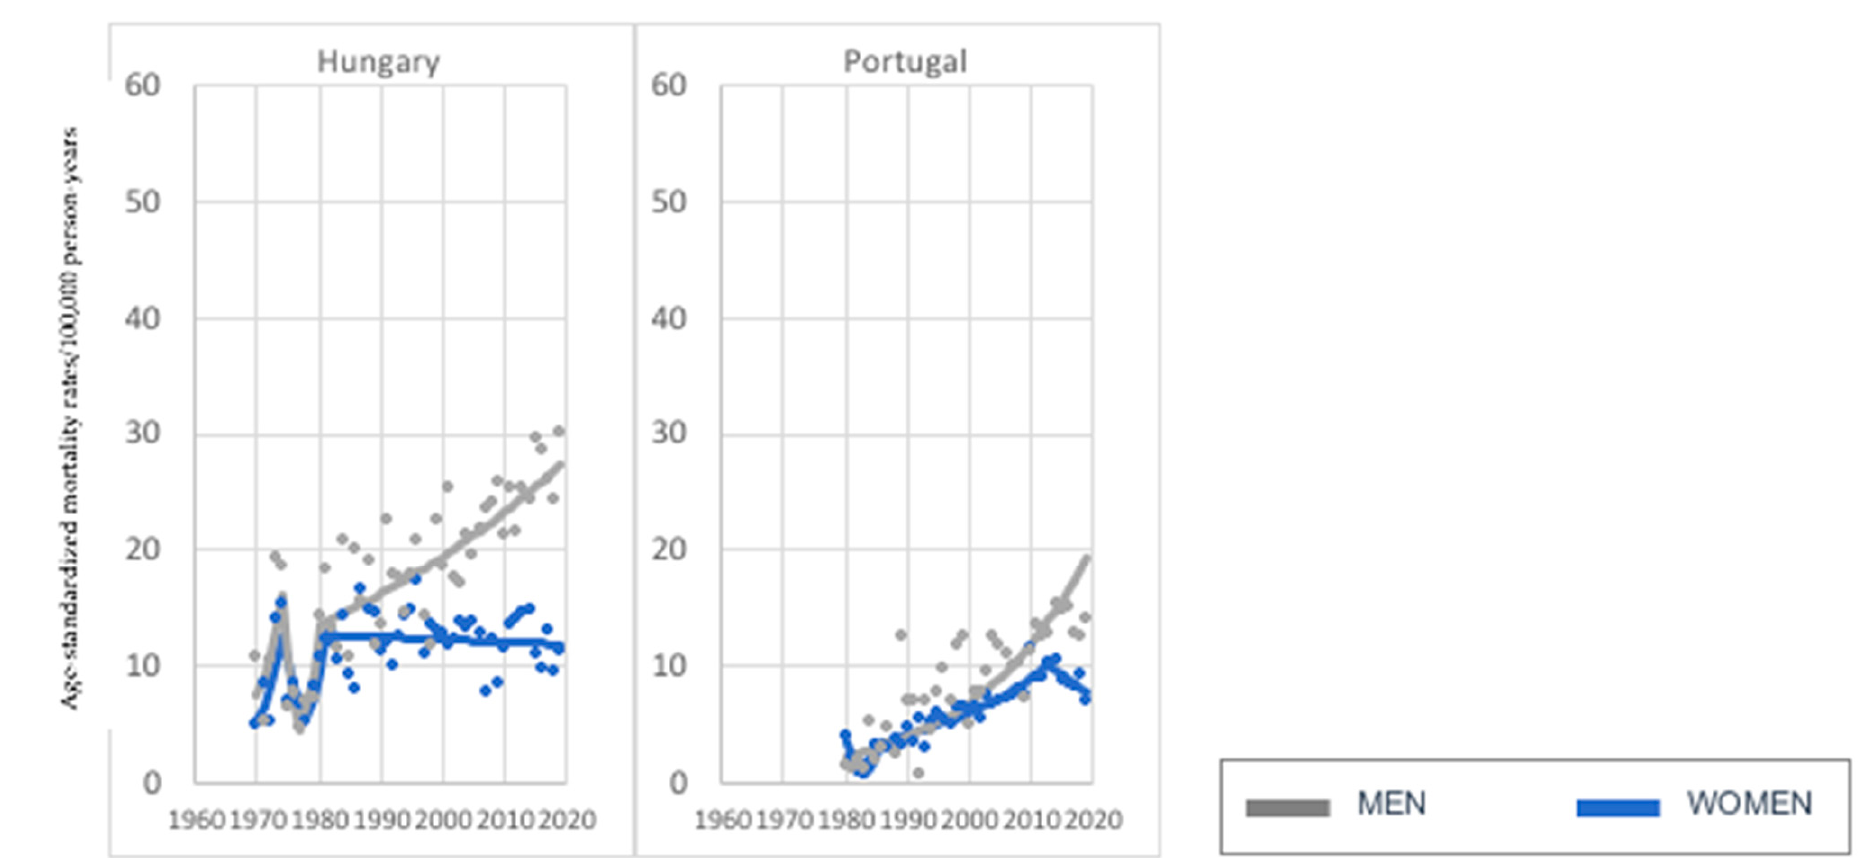
Figure 7. Melanoma mortality trends—2 countries with an investigated decrease in women and increase in men, age group 75+ years old.